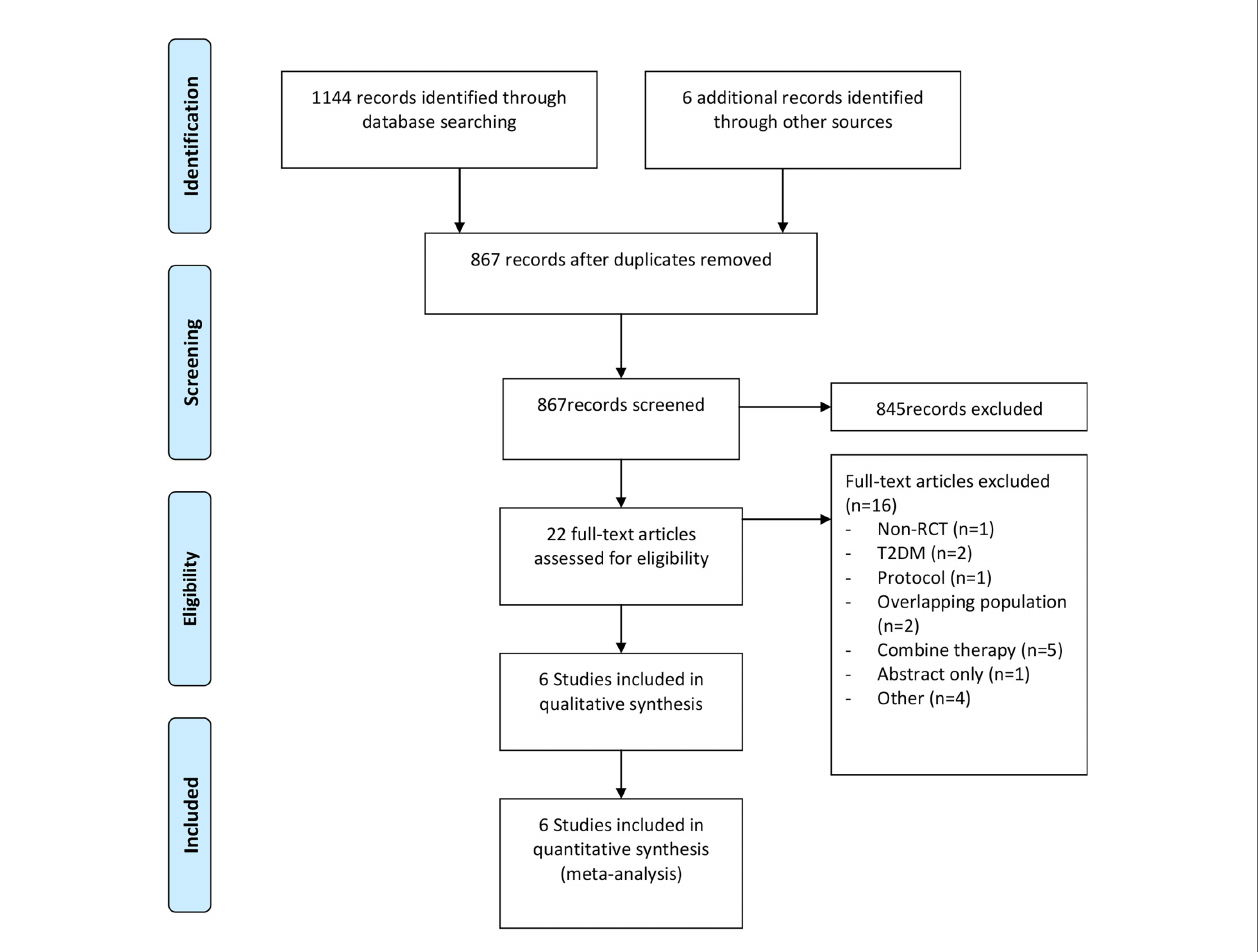
FIGURE 1 | Flow diagram for study identi fi cation and